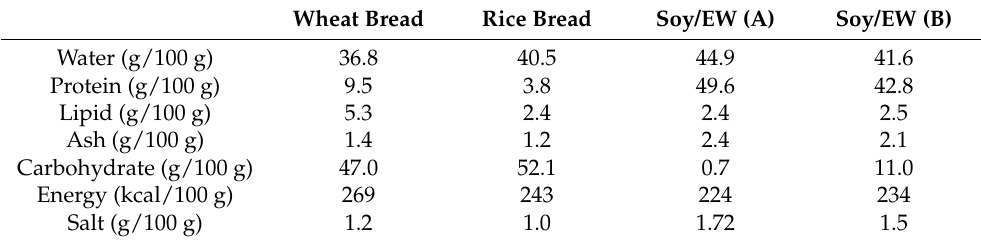
Table 2. Comparison of the nutrition composition among the breads. Wheat Bread